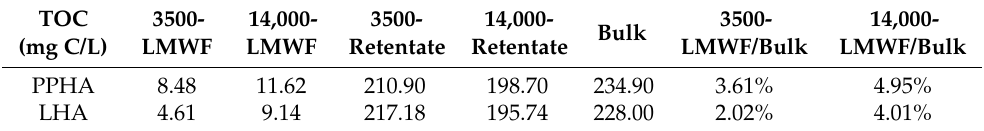
Table 1. TOC contents of different molecular weight fractions of LHA and PPHA after 72 h dialysis.